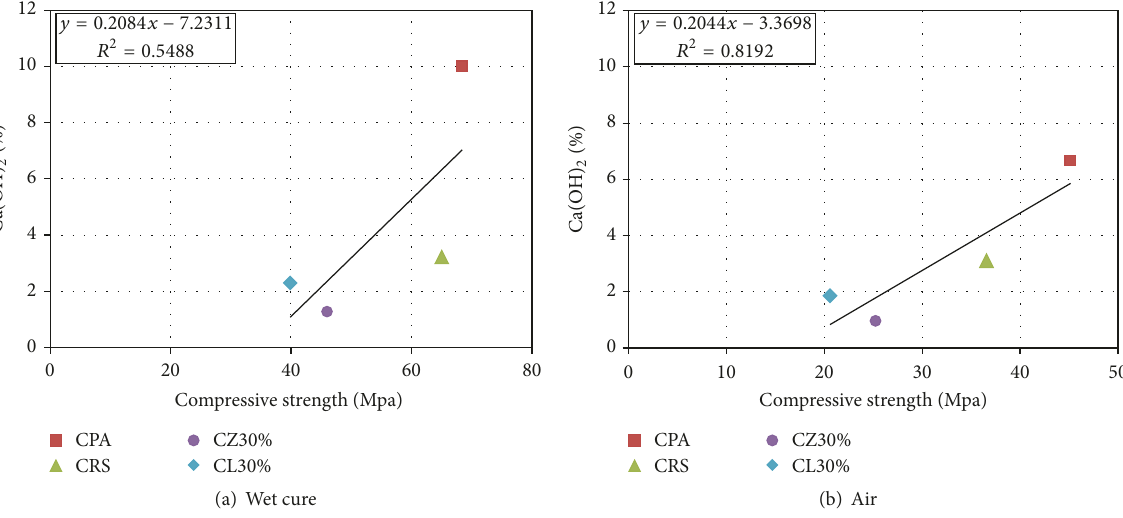
Figure 15: Portlandite content as a function of compressive